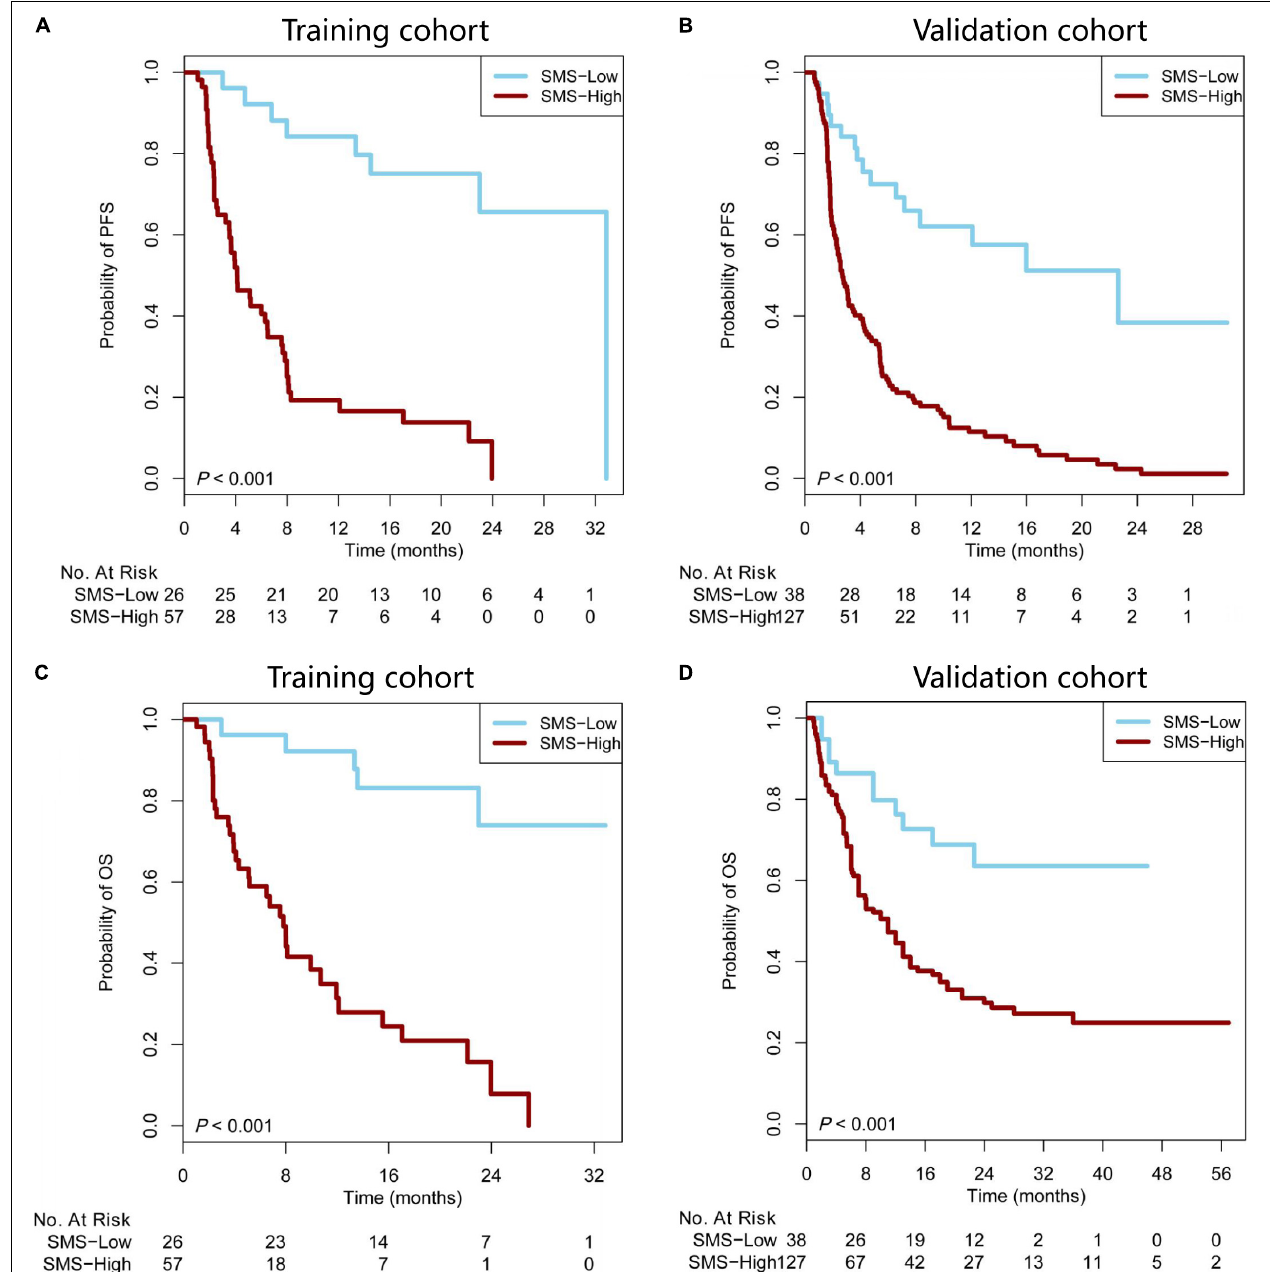
FIGURE 3 | The SMS predicts PFS and OS in patients with immunotherapy. (A,B) Kaplan–Meier survival curves showing PFS between the SMS-low and -high groups in patients from the training and validation cohorts treated with anti-PD-1 therapy. (C,D) Kaplan–Meier survival curves showing OS between the SMS-low and -high groups in patients from the training and validation cohorts treated with anti-PD-1 therapy. SMS, somatic mutation signature; PFS, progression-free survival; OS, overall survival; NR, not reached; PD-1, programmed cell death